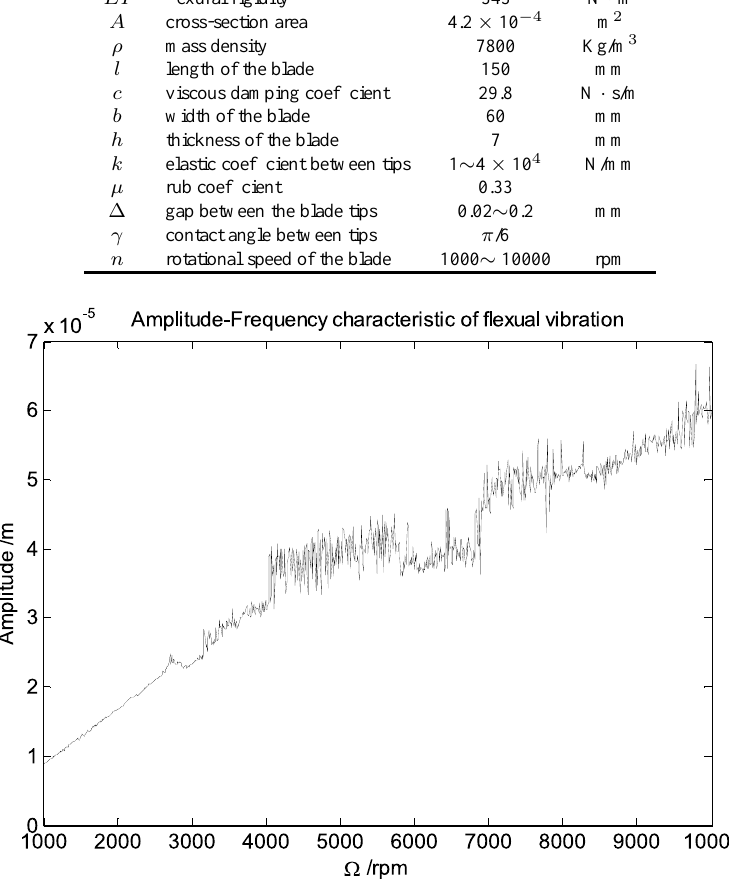
Fig. 3. Amplitude frequency characteristics of the flexural vibration of the